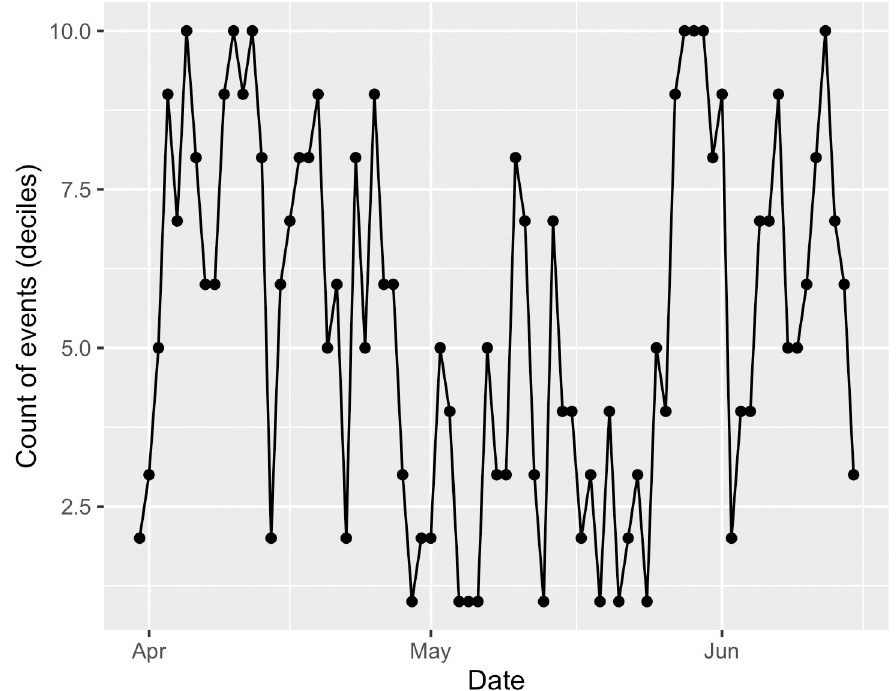
Fig 7. Example of deciled data.